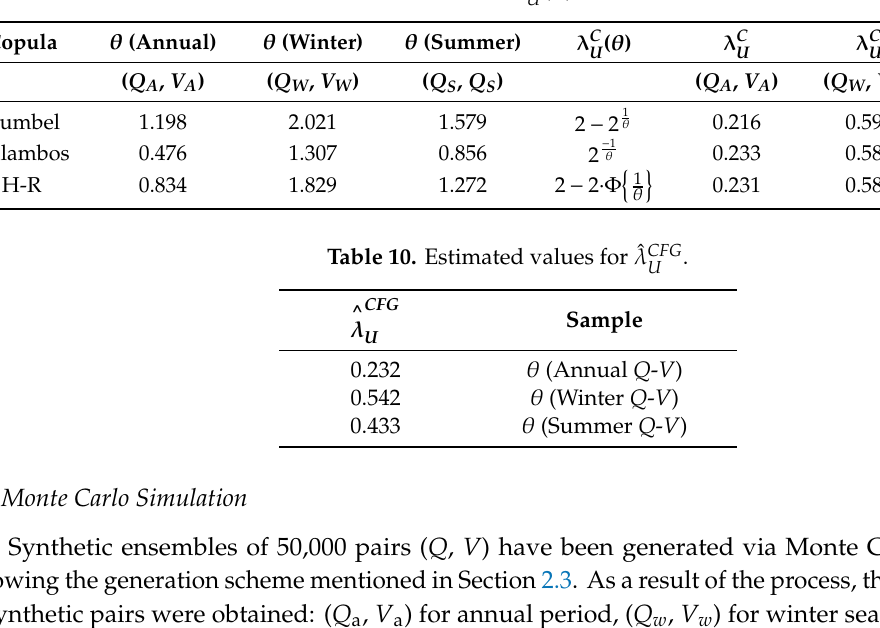
Table 9. θ and λ C